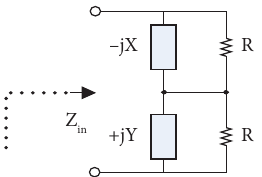
Figure 6: Te modifed RCN (two reactance components having diferent amplitude and phase).